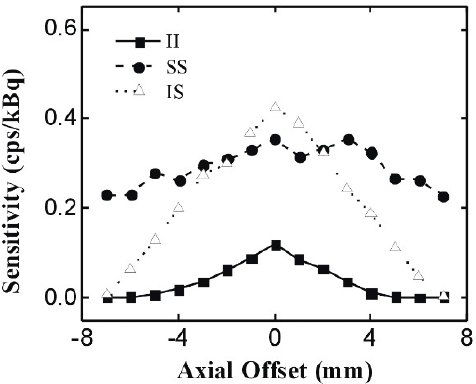
Figure 4. System sensitivity distribution in the axial directions, with an energy window of 350 to 650 keV PET imaging of point source and phantom.